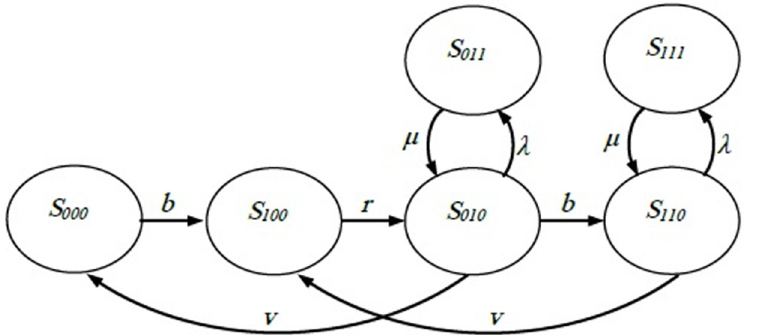
Fig 2. State transition diagram of single-machine